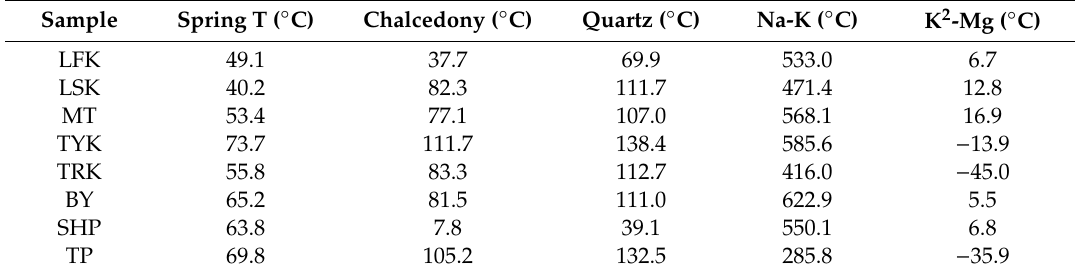
Table 3. Geothermometer results of Tatun geothermal field hot spring waters.